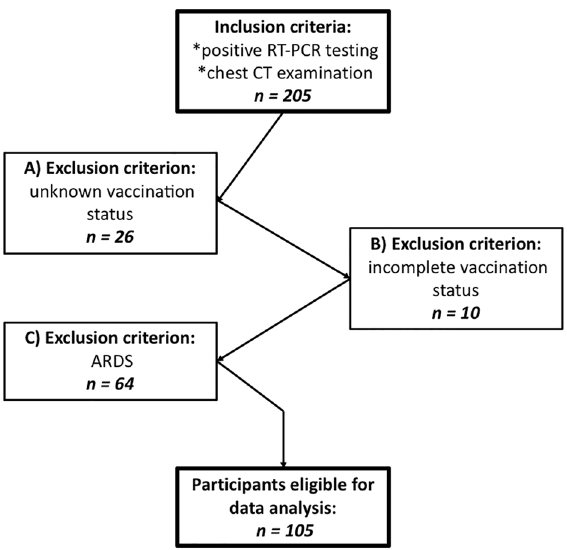
Figure 1. Study Flowchart. Patients’ inclusion and exclusion criteria with representation of included and excluded number of